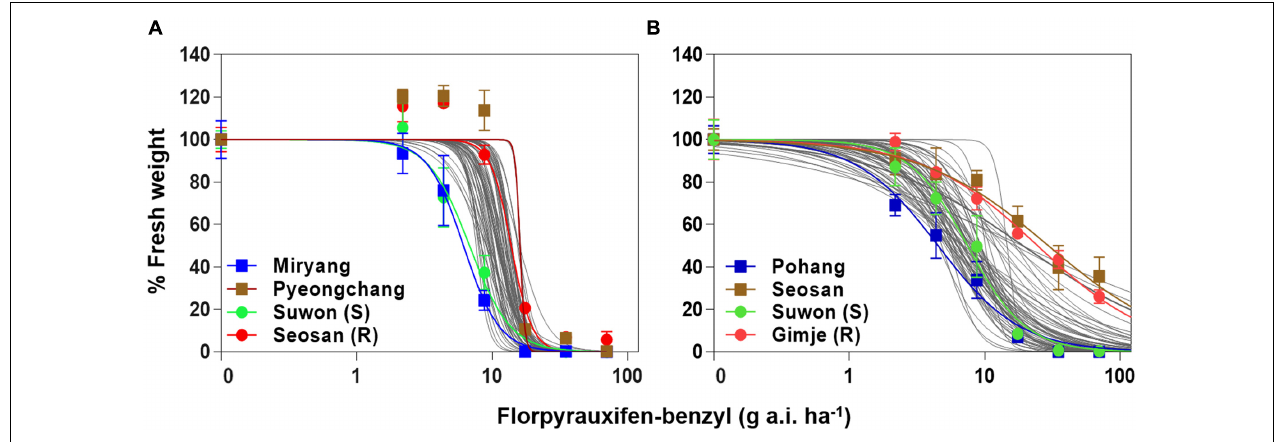
FIGURE 2 | Dose-response curves in fresh weight (% control) of (A) Echinochloa crus-galli accessions and (B) Echinochloa oryzicola accessions measured at 30 days after florpyrauxifen-benzyl